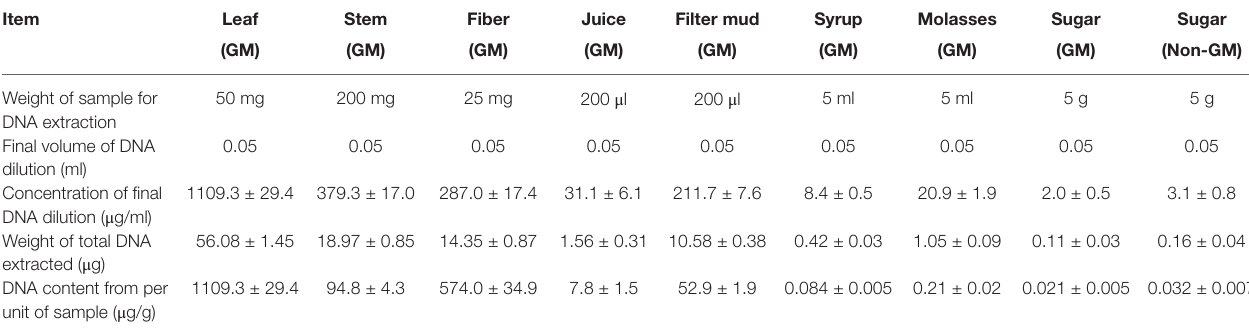
TABLE 3 | DNA concentrations of all samples.